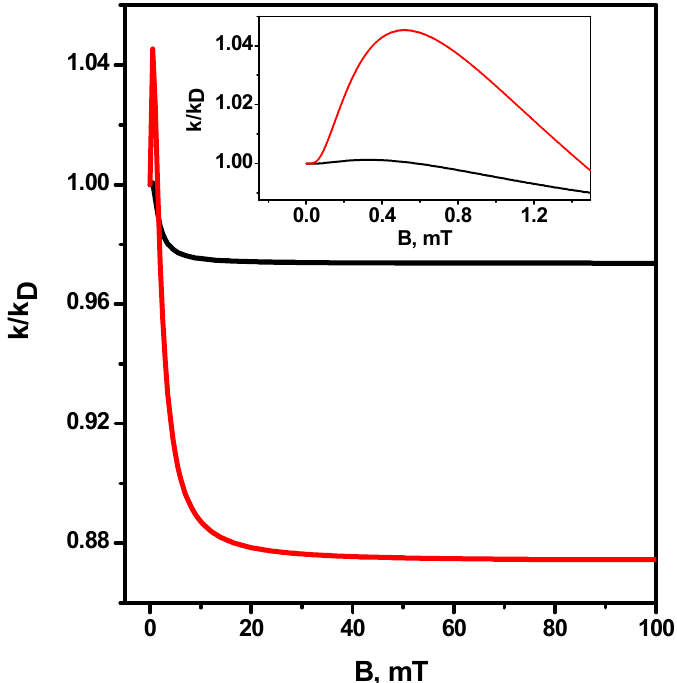
Figure 6. Magnetic field effect k(B)/k(B = 0) for equal g-factors of radicals, g 1 = g 2 = 2.0 The black line corresponds to D = 2.0 · 10 − 5 cm 2 , the red line corresponds to D = 2.0 · 10 − 8 cm 2 eters are the same as in Figure 1. Insertion—the magnetic field effect on a smaller scale.